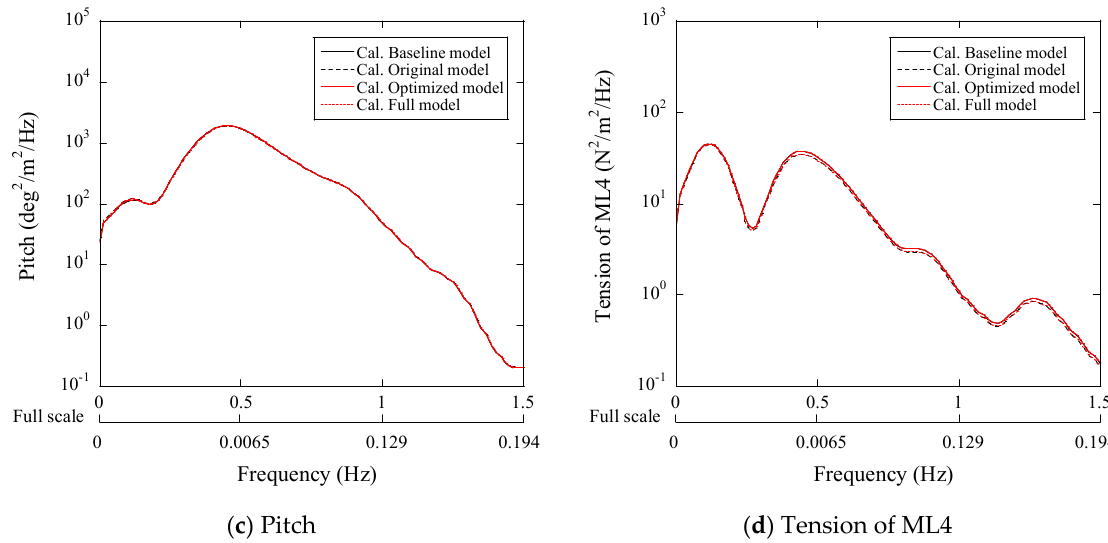
Figure 14. Comparison of the normalized dynamic responses of three platforms in the irregular waves ( H = 0.195 m, T = 2.16 s).